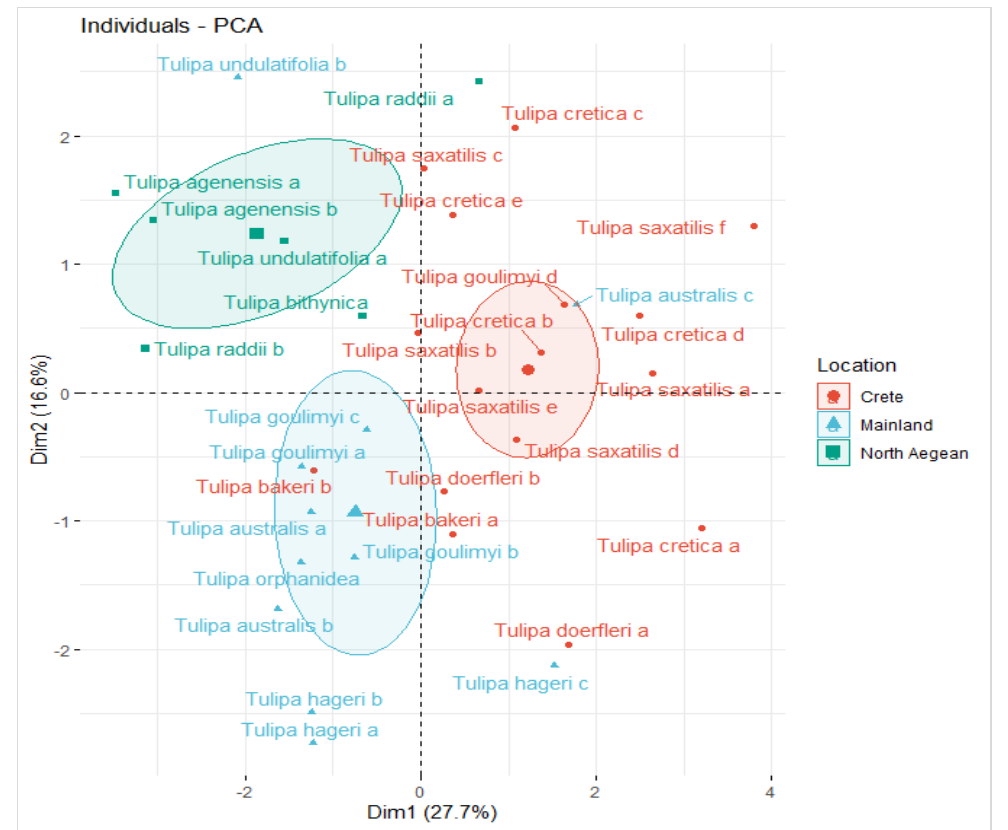
Figure 4. Principal component analysis (PCA) of ( a ) the studied macro- and micro-nutrients of tulips’ above-ground biomass (vectors), and ( b ) the respective contribution of each component to their total variability.